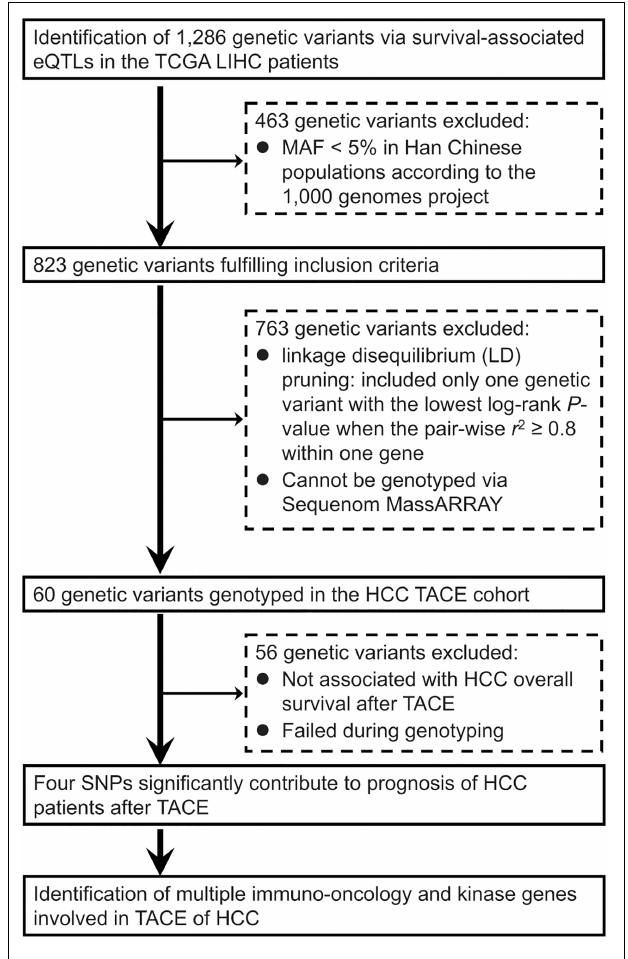
FIGURE 1 | Flowchart of an integrative functional genomics methodology to identify survival-related expression quantitative trait locus (eQTL) genetic variants involved in the transarterial chemoembolization (TACE) treatment of hepatocellular carcinoma (HCC) across the whole